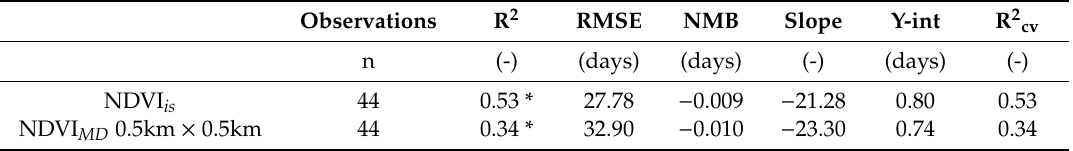
Table 6. Relationship between the start of season (SOS) of GPP derived from eddy covariance data (days) and the start of greenness derived from NDVI is and NDVI MD at a spatial resolution of 0.5 × 0.5 km. Observations: Number of available days; R 2 : Root mean square error; RMSE: Root mean square